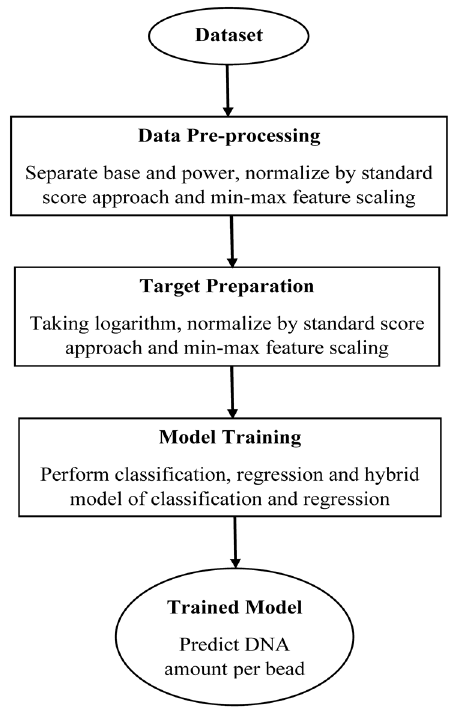
Figure 2. Overview of the proposed framework for prediction of DNA amount per bead.